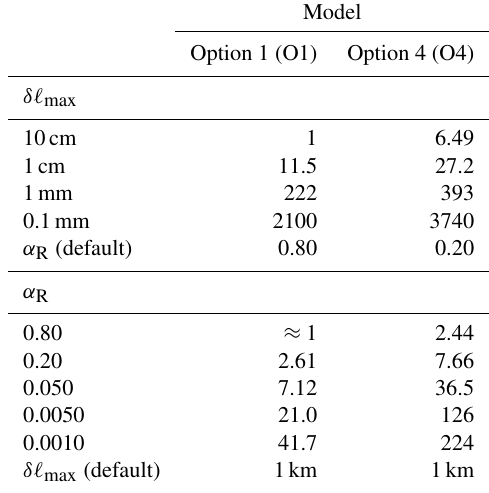
Table A1. Computation time needed by different Geant4 configu- rations for the simulation of the same physical problem, relative to the Geant4 O1 δ(cid:96) max = 10cm case. Two parameters are tested: the maximum allowed step ( δ(cid:96) max ) and the “dR over range” ( α R